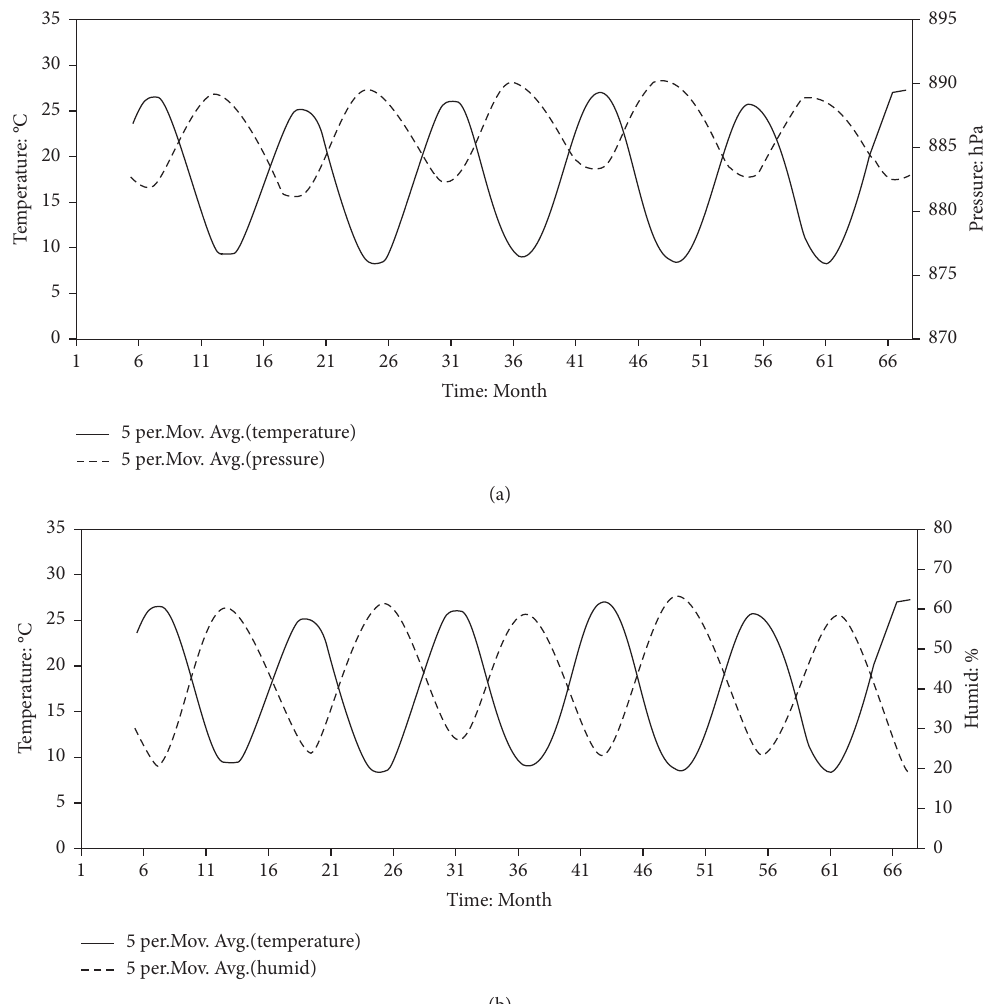
Figure 8: The 5-month moving average with a 5-month window: (a) temperature-pressure; (b): temperature-relative